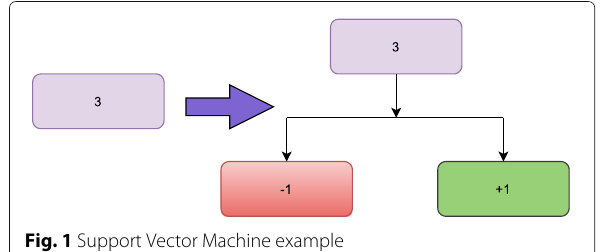
Fig. 1 Support Vector Machine example suicidal and not suicidal based on the suicidal dictionary feature. Mathematically, Naive Bayes and Naive Bayesian